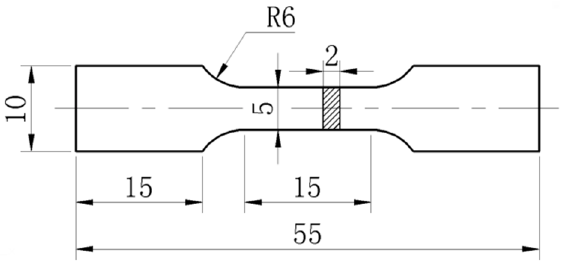
Figure 3. Dimension of the specimen for tensile testing (unit: mm).